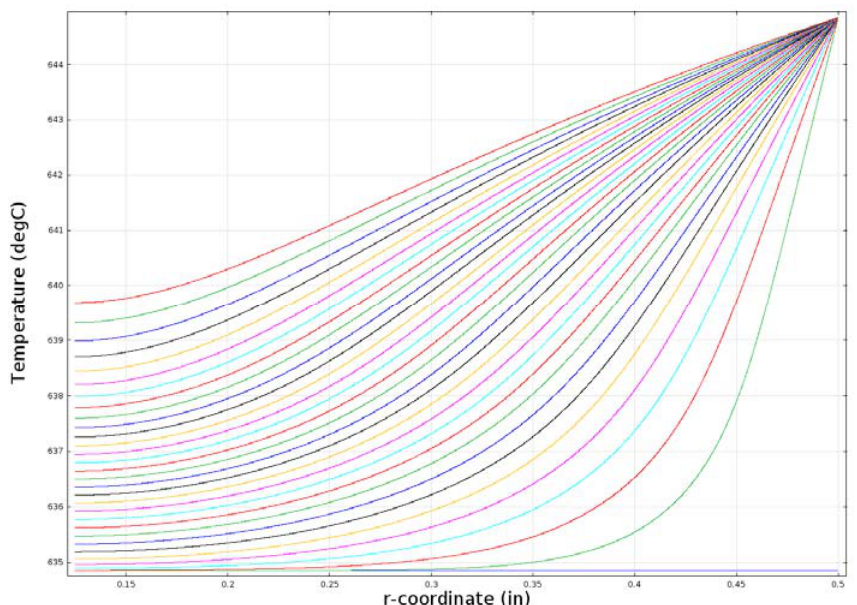
Figure 10. Modeled temperature profile in a one inch-diameter cylindrical bed (k = 0.2